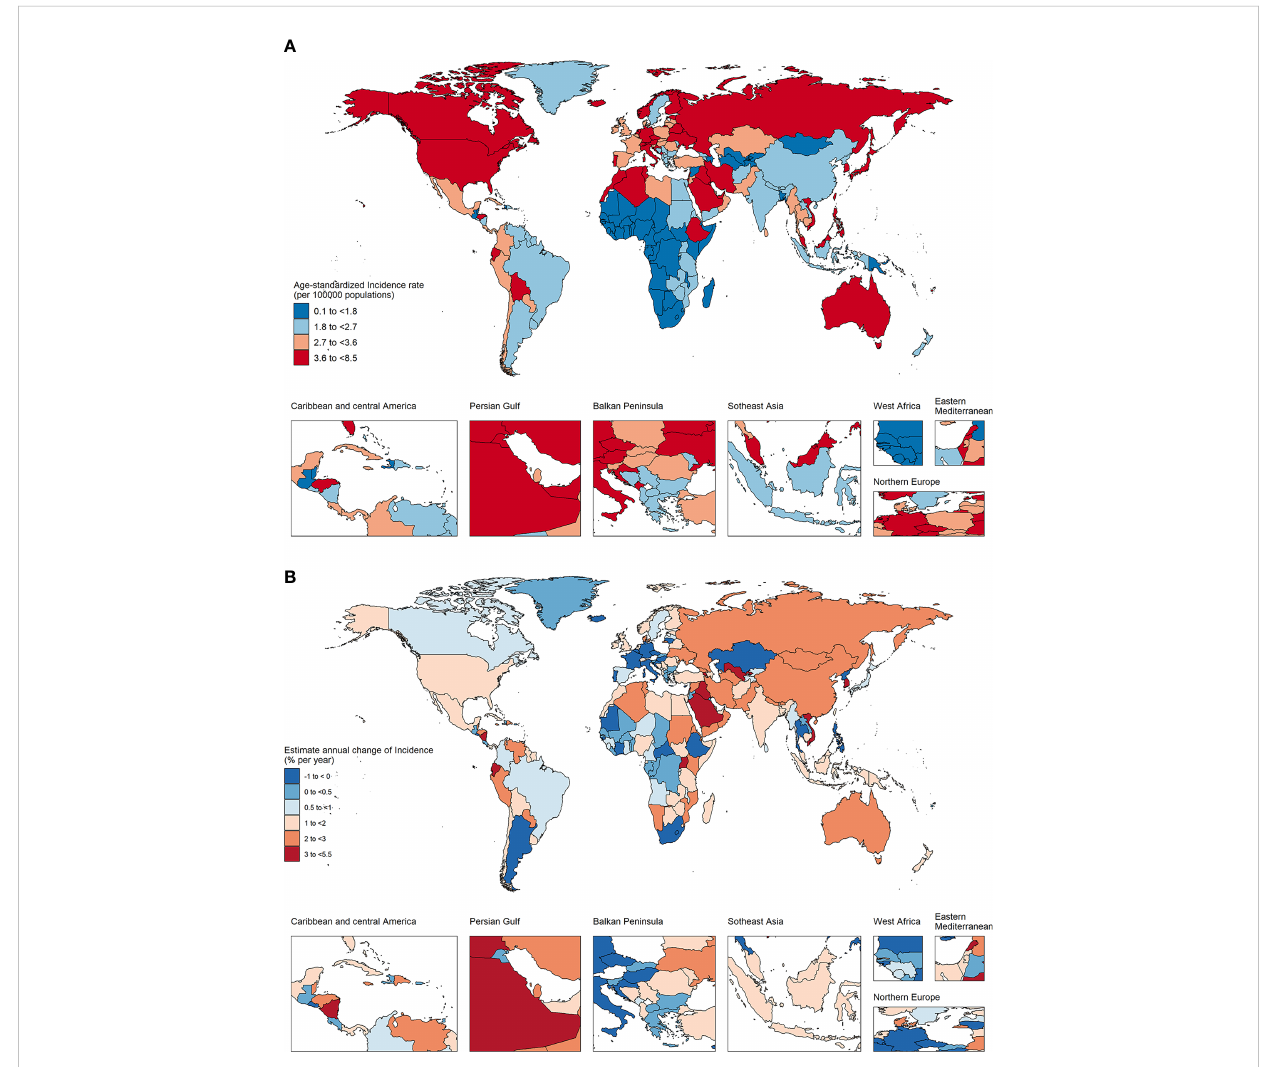
FIGURE 3 The age-standardized incidence in 2019 (A) and net drift of incidence during 1990~2019 (B) for TC in 204 countries and territories (A) World map of age-standardized incidence for TC in 2019, (B) World map of net drifts for TC incidence, ie, estimated annual percentage change of incidence from age-period-cohort model. Net drift captures components of the trends attributable to calendar time and successive birth